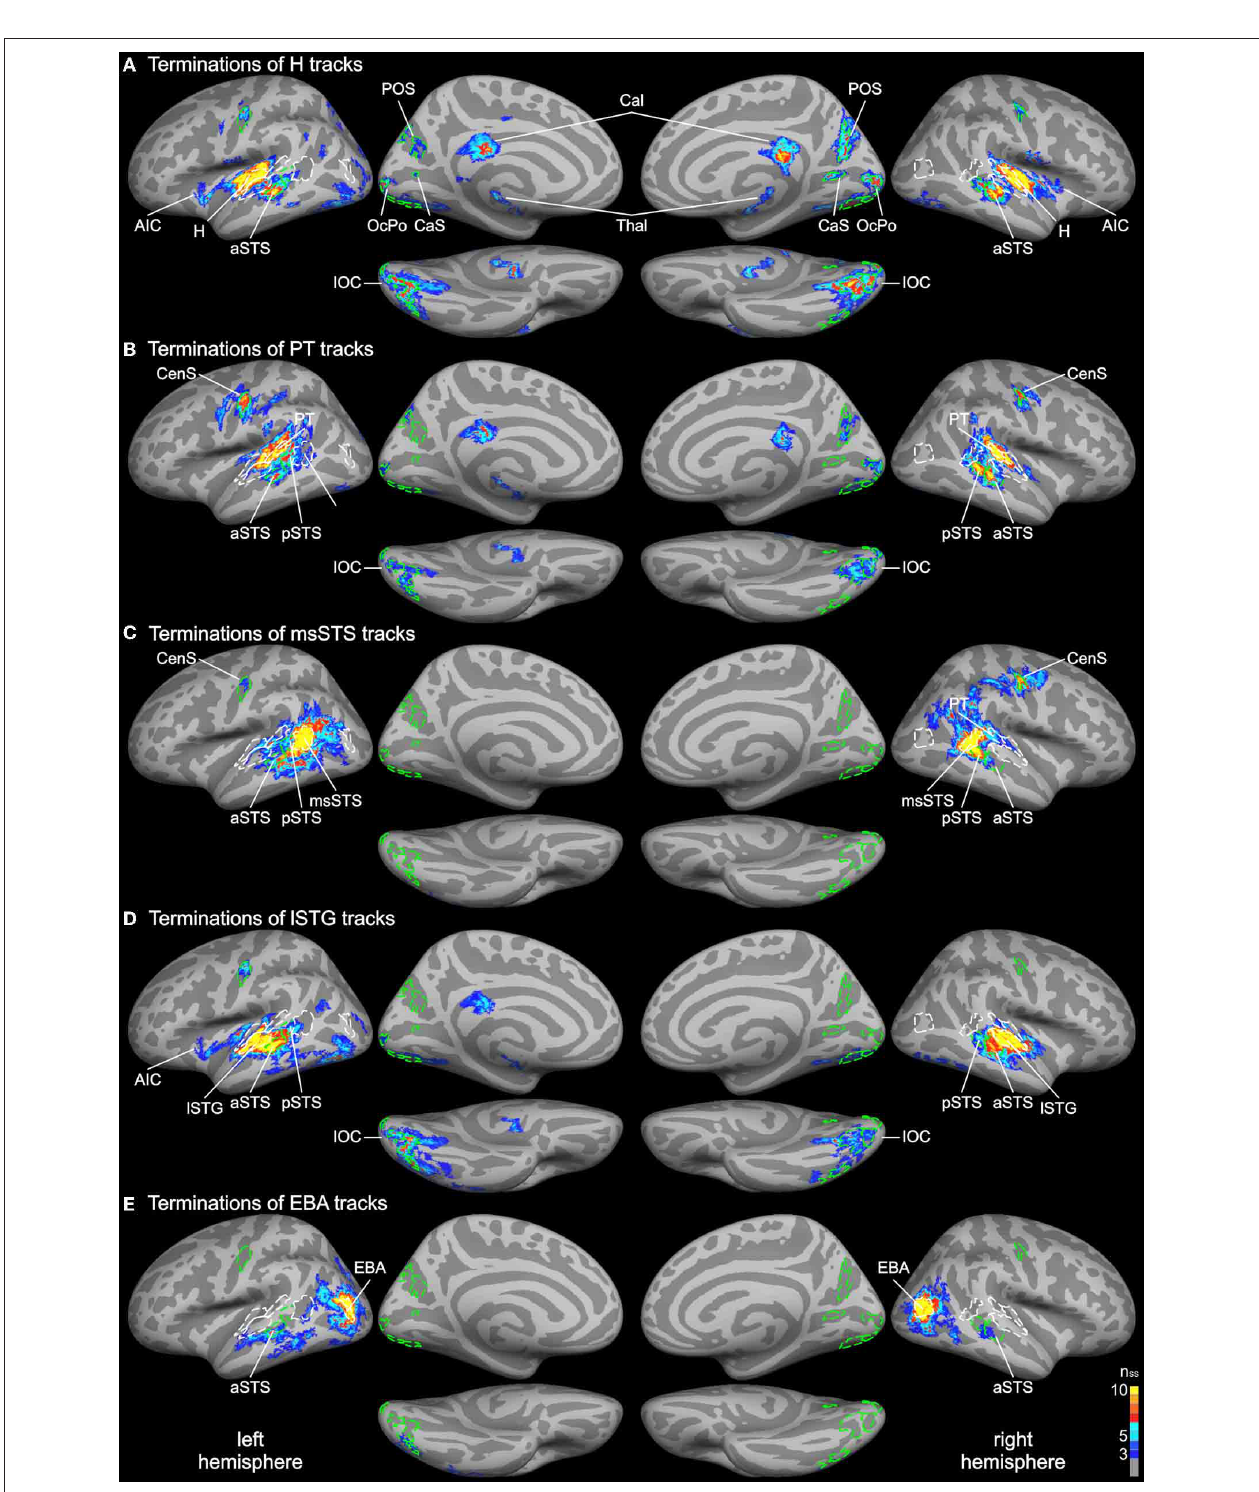
FIGURE 3 | Group average track termination maps overlaid on cortical surfaces of the MNI standard brain. Termination maps were thresholded to n ss = 3. Color scale: dark blue, terminations found in three hemispheres (threshold); yellow, terminations found in all hemispheres. The different panels show separate termination maps for tracks seeded in (A) Heschl’s region (H), (B) planum temporale (PT), (C) multisensory STS (msSTS),